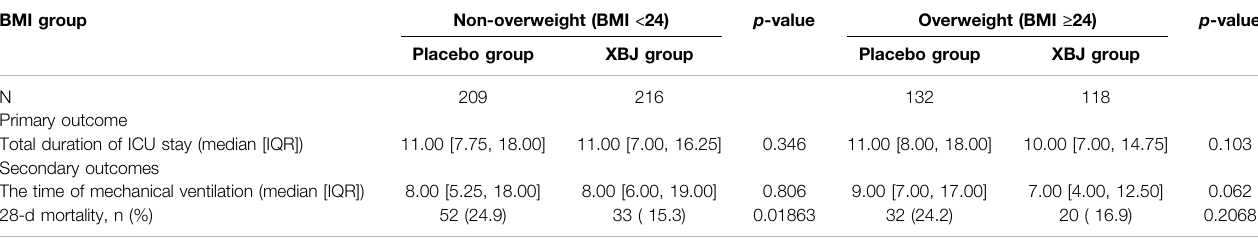
TABLE 5 | Primary and three secondary outcomes in the BMI group. BMI group